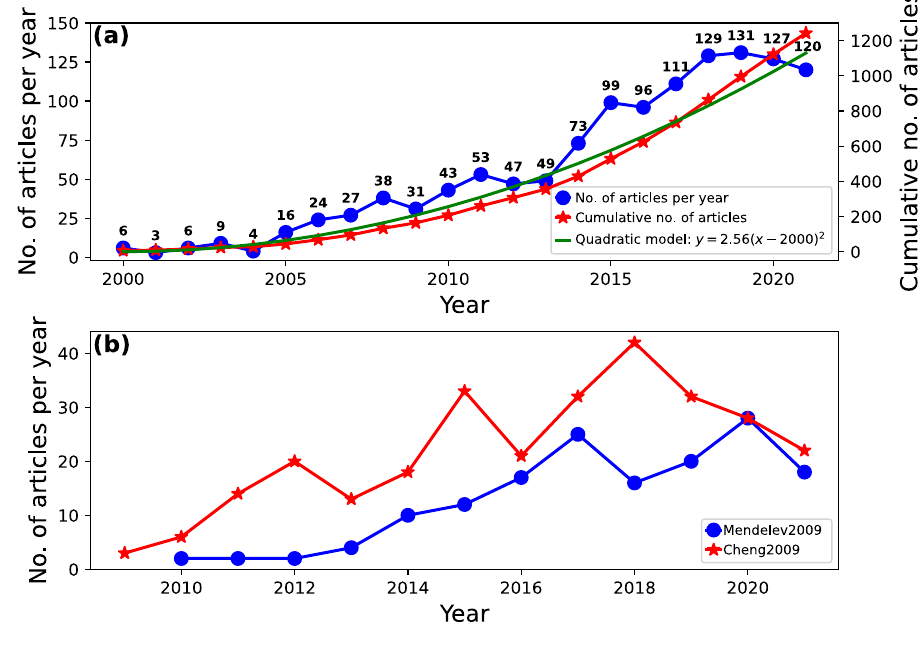
Fig. 2 Number of articles published each year, accu- mulated number of articles, and analytical model for the growth of